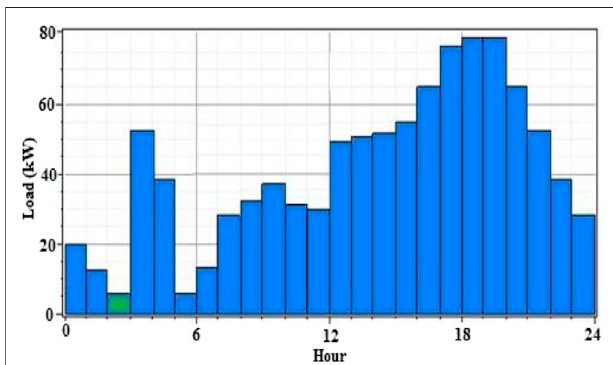
FIGURE 4 | Load demand of an isolated hybrid grid throughout a